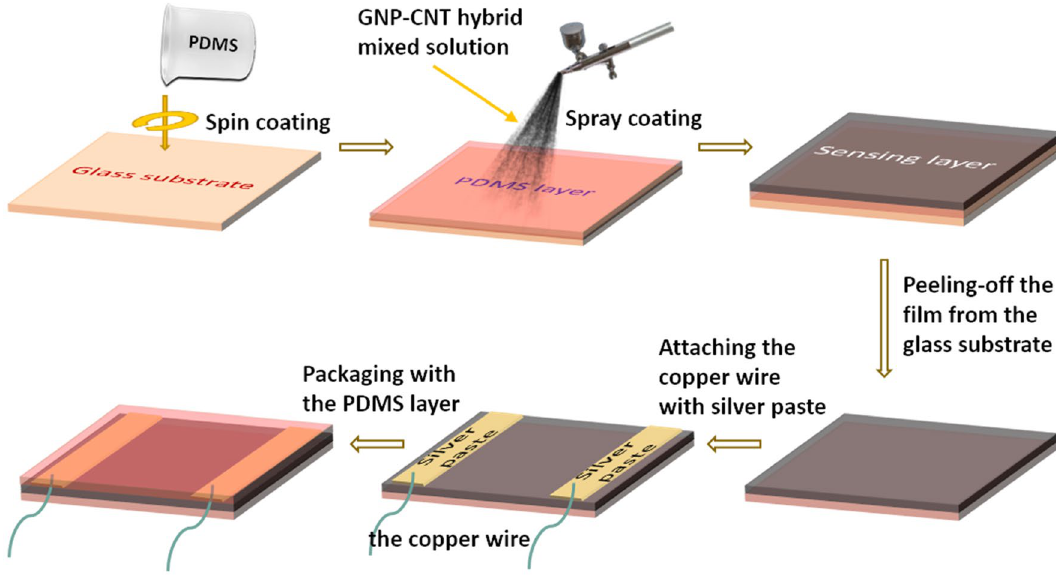
Figure 1. Schematic showing the key steps of fabrication process for the GNP-CNT hybrid thin film based flexible strain sensor by spray coating method. By monitoring the resistance change, tensile strain on the film plane can be